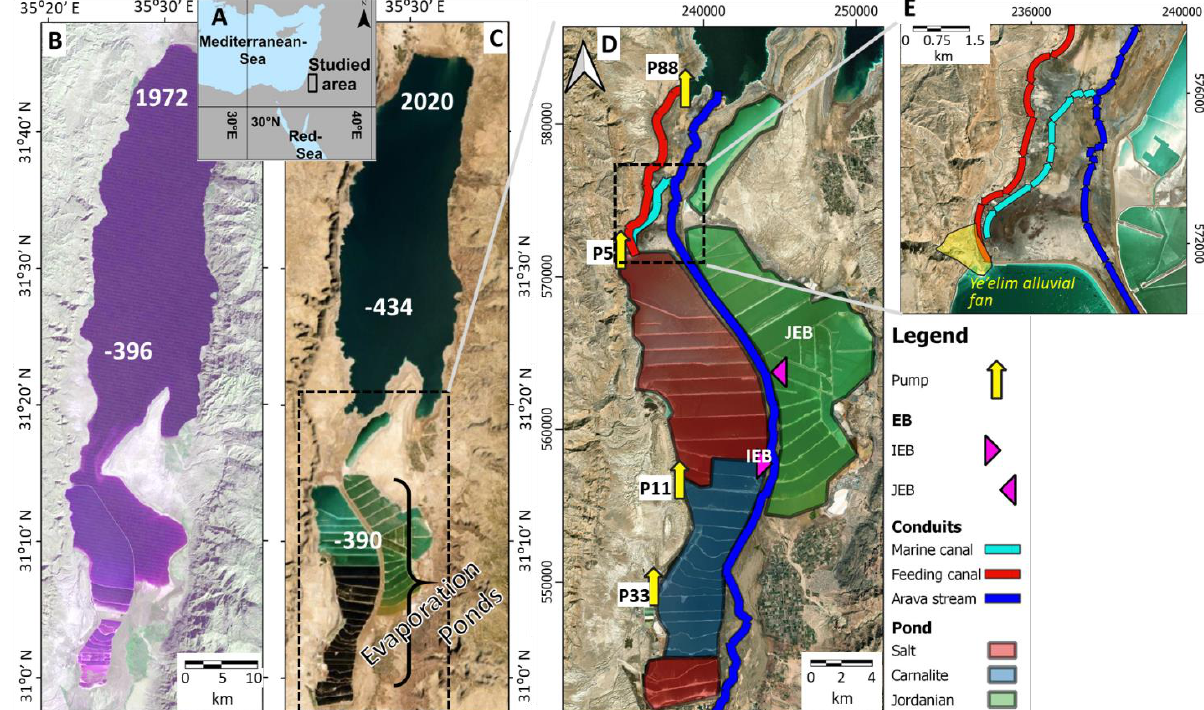
Figure 1. Map of the studied area ( A ). Satellite images of the Dead Sea in 1972, prior to its drying, when the northern and southern basins were connected and had an equal level of 396 mbsl ( B ), and in 2020, when the northern basin level dropped to 434 mbsl, and the level of the evaporation ponds rose to 390 mbsl ( C ). Enlargement of the evaporation pond area ( D ) showing the locations of the pumping stations (P88, P5, P11, P33), the Israeli and Jordanian end brine discharge points (IEB and JEB, respectively) and the Arava stream route. Enlargement of the leakage zone ( E ) showing the brine flow routes and the alluvial fan of the Ye’elim wadi (yellow stain). Coordinates of maps D and E (and in the following figures) are of the Israel TM grid system.